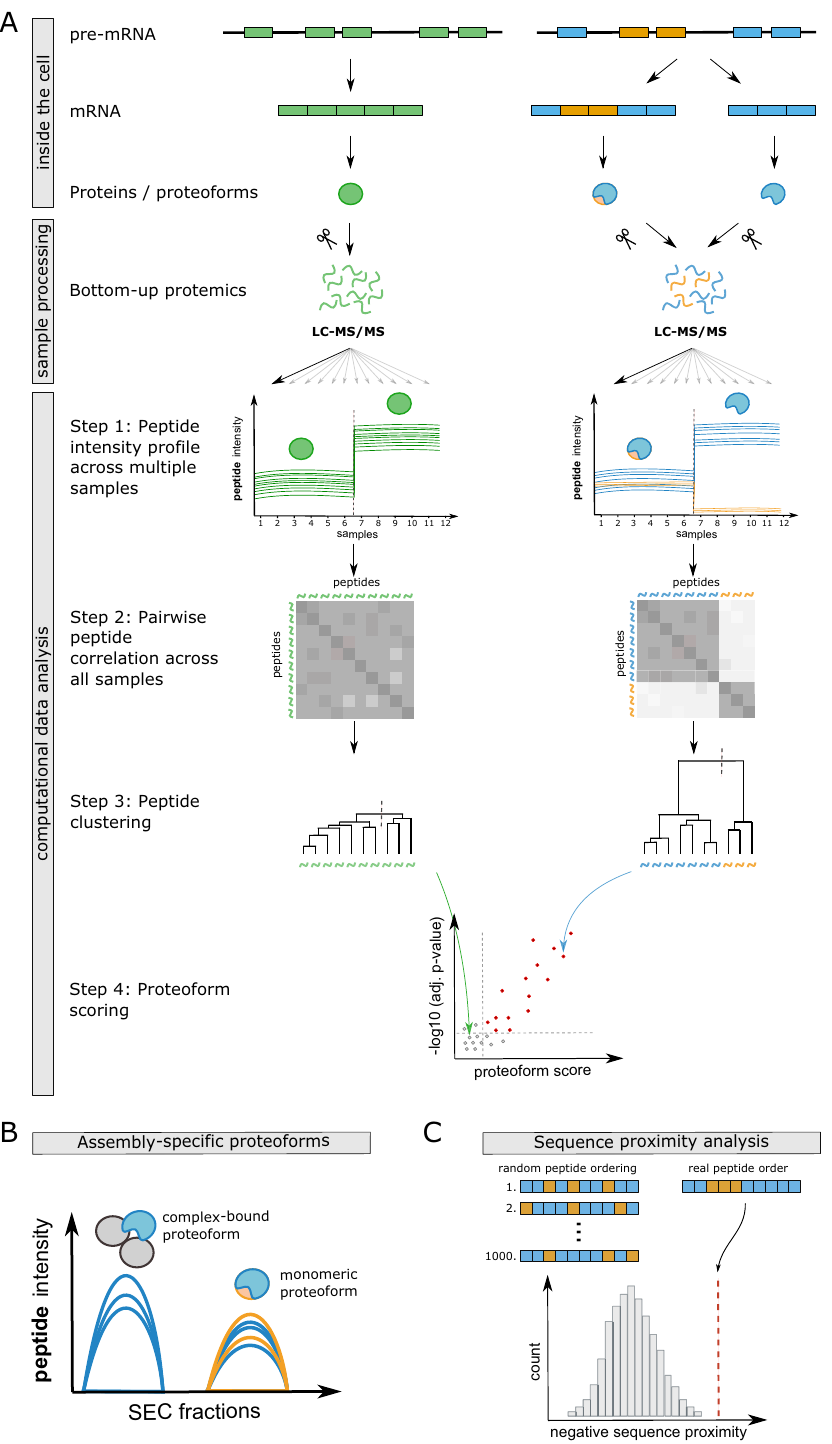
speci fi cally designed for detecting proteoforms differing by a single peptide and could, therefore, achieve a convincing ROC curve. In the second benchmarking set, proteoform groups dif- fered by two peptides, and COPF and PeCorA show similar ROC curves (Fig. 2 middle panel and Supplementary Fig. 1A). Here, COPF has slightly higher TPRs in the lower range of FPRs between 0 and 0.1. Finally, COPF markedly outperformed PeCorA in the third benchmarking set in which proteoform